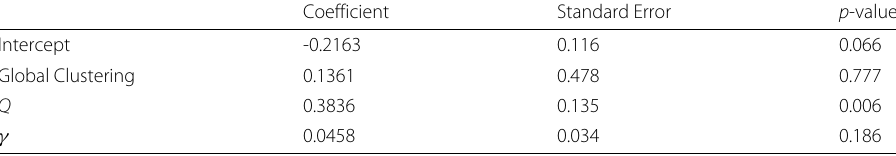
Table 2 Coefficients of a linear regression using the output of our NOL-HTR parameter search